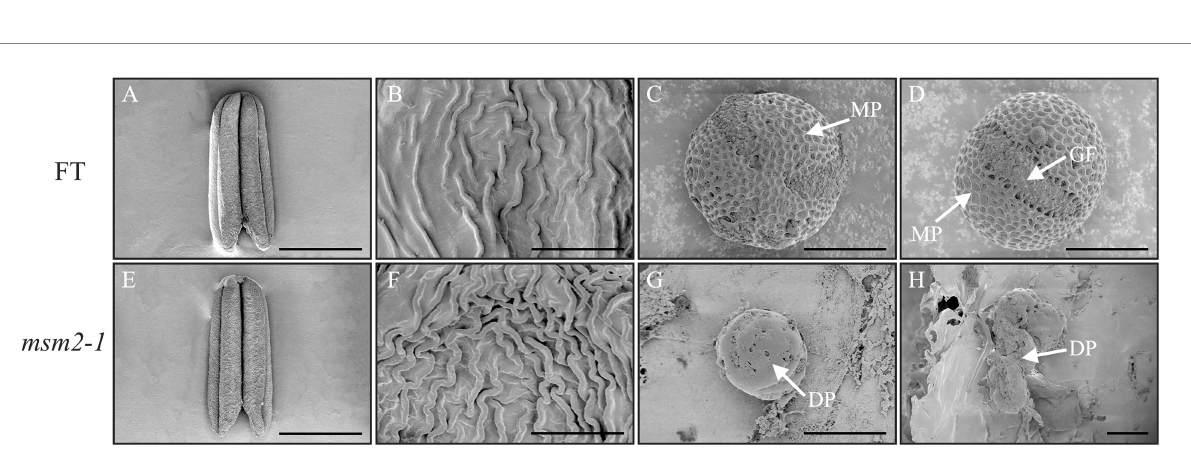
FIGURE 3 SEM analysis of the anthers and pollen grains in the wild-type “FT” and msm2-1 mutant. The anthers of the wild-type “FT” (A) and msm2-1 mutant (E) . Scale bar, 1 mm. The anthers epidermis of the wild-type “FT” (B) and msm2-1 mutant (F) , Scale bar. 5 μ m. The surface on the pollen exine of the wild-type “FT” (C,D) and msm2-1 mutant (G,H) . MP mature pollen grains. GF germinal furrow, DP degenerated pollen grains. Scale bar, 10 μ